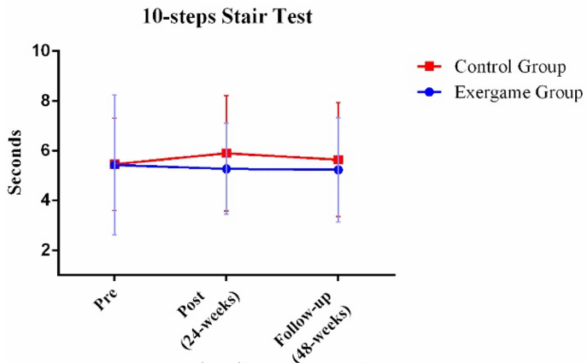
Figure 2. Comparison between exergame and control groups in the three time points for the Chair Stand Test. * The exergame group significantly increased the number of repetitions ( p -value < 0.05); ‡ The control group significantly decreased the number of repetitions ( p -value < 0.05).